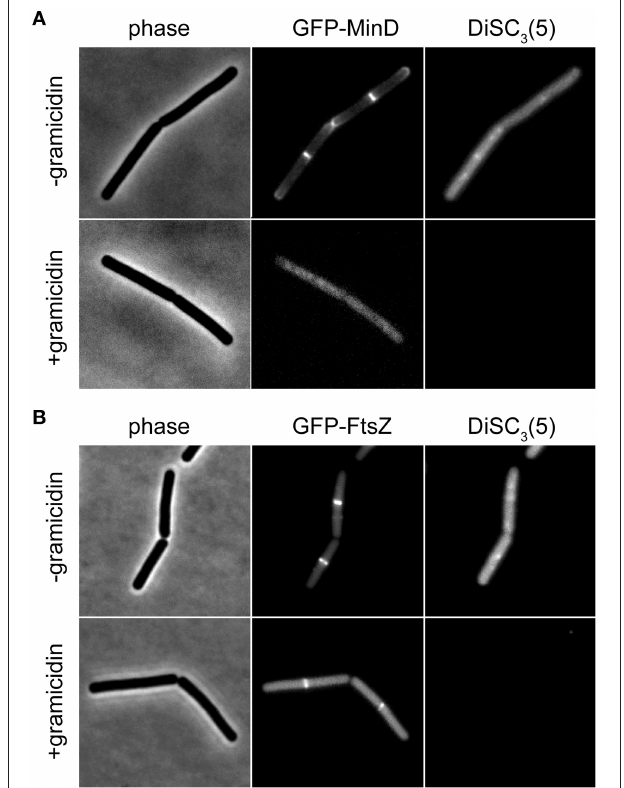
FIGURE 6 | Compatibility of DiSC 3 (5) and GFP in microscopic single-cell experiments. (A) Phase contrast image (left panel) of cells expressing GFP-MinD (middle panel) and stained with DiSC 3 (5) (right panel) in the absence and presence of gramicidin (5 µ M). Note the strong decrease in DiSC 3 (5) fluorescence and delocalization of MinD upon depolarization. (B) Phase contrast image (left panel) of cells expressing GFP-FtsZ (middle panel) and stained with DiSC 3 (5) (right panel) in the absence and presence of gramicidin (5 µ M). Note the reduced septal signal of FtsZ upon depolarization. Strains used: B. subtilis KS64 (GFP-MinD), and B. subtilis 2020